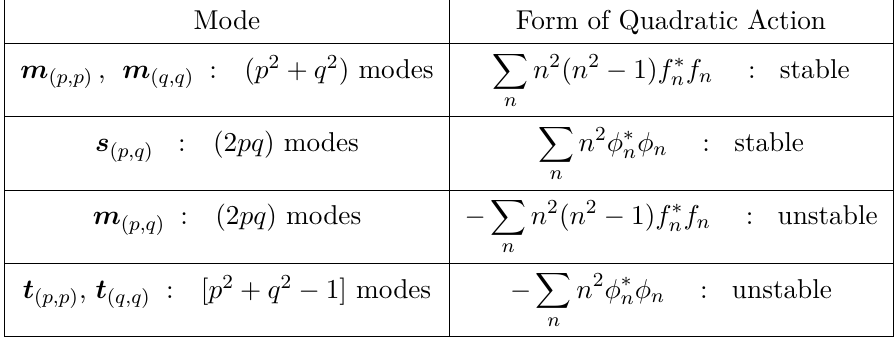
Table 1 . The form of quadratic actions of each boundary